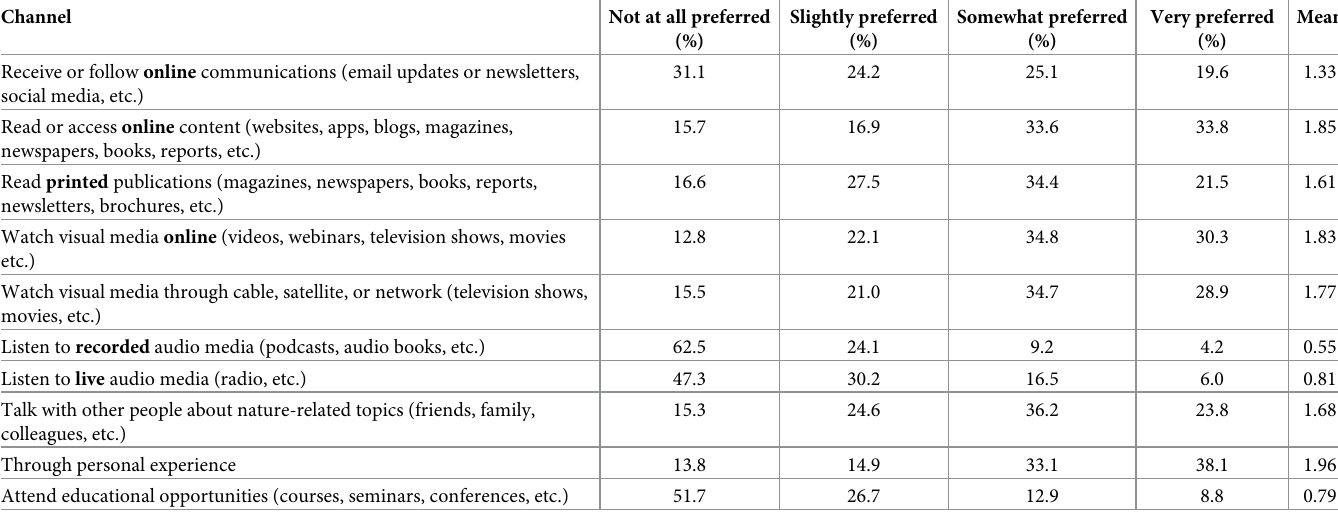
Table 3. Preferences for channels of information on nature-related topics. Channel Not at all preferred